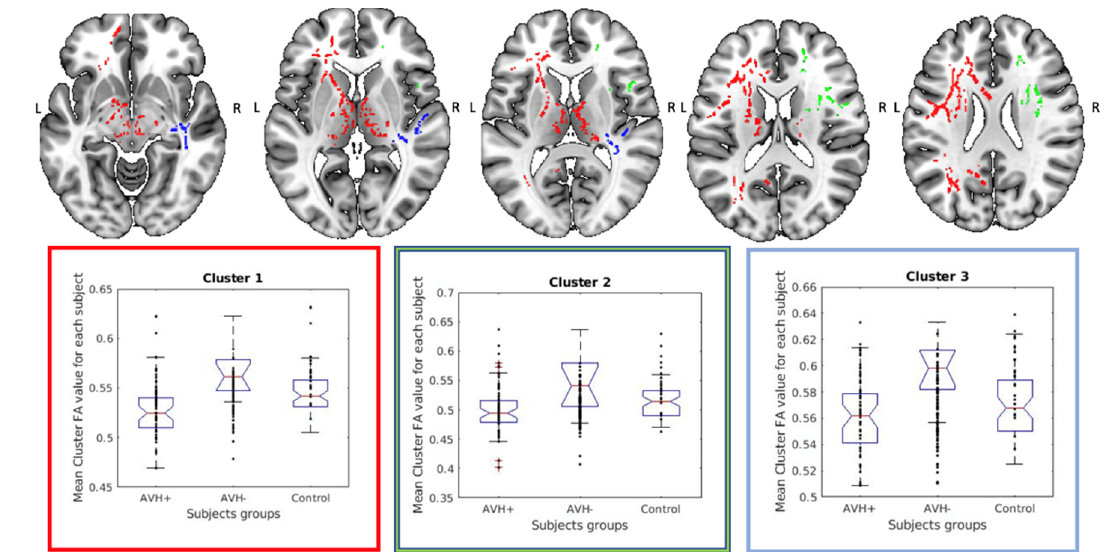
Figure 1. Upper row shows the localization and distribution for the three largest significant clusters, (cluster 1 marked in red, cluster 2 marked in green, and cluster 3 marked in blue) obtained from the comparison between the AVH+ and AVH − groups. The box plot graphs in the lower row shows the corresponding mean clusters Fractional Anisotropy (FA) values for each participant in each group (AVH+, AVH − , Control). The color of the graph frame matches the color of the cluster it belongs to). The central mark indicates the median, and the top and bottom edges of the box represent the 25th and 75th percentiles, respectively. The whiskers extend to the most extreme data points not considered outliers, while the outliers are plotted individually and marked with a plus symbol. Data were merged for the two control groups and presented as a single control group for facilitation of comparison with the patient groups.